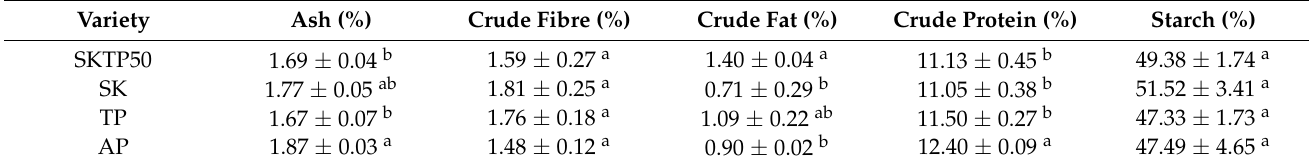
Table 3. Compositional analyses performed on rye flours. The nutrient composition is expressed on a dry matter (DM)